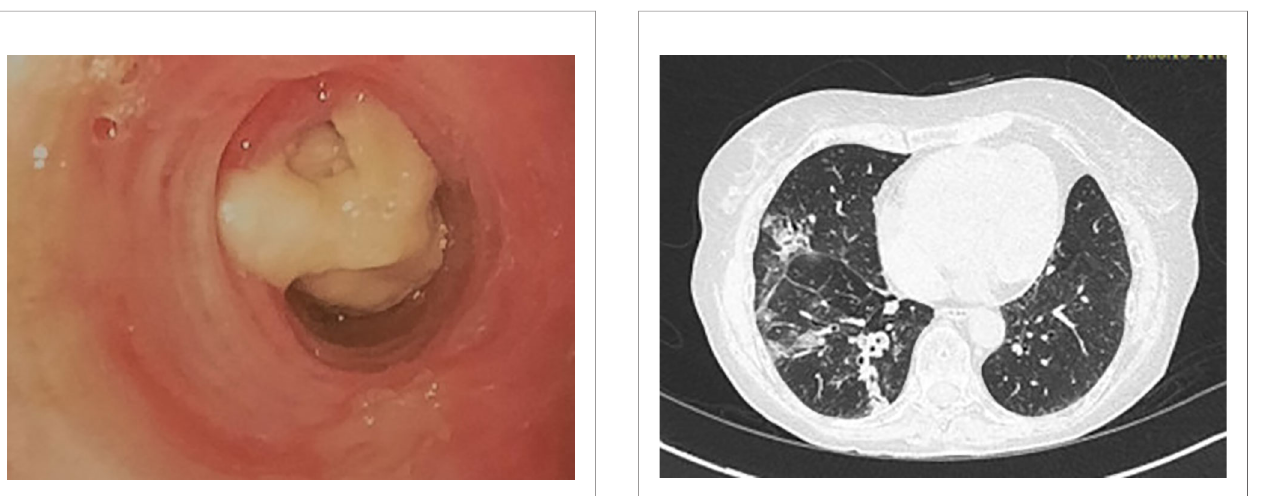
FIGURE 3 | Complete obstruction of the left strain bronchus by sticky greenish material in fl exible bronchoscopy.